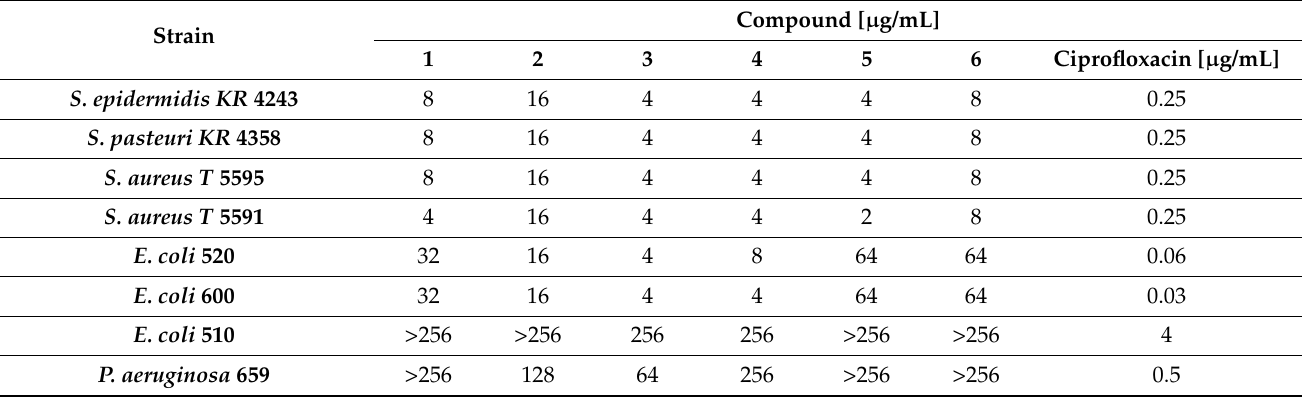
Table 4. Activity of Ciprofloxacin menthol derivatives against clinical bacteria strains, expressed by minimal inhibitory concentrations ( µ g/mL).